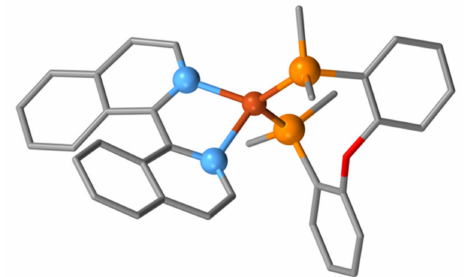
Figure 16. One of the enantiomeric [Cu(POP){(1 M )-biiq}] + cations present in [Cu(POP){(1 MP )- biiq}](PF 6 ) The donor atoms and copper are shown as balls and hydrogen atoms omitted for clarity with only the ipso carbon atoms of the Ph 2 P groups